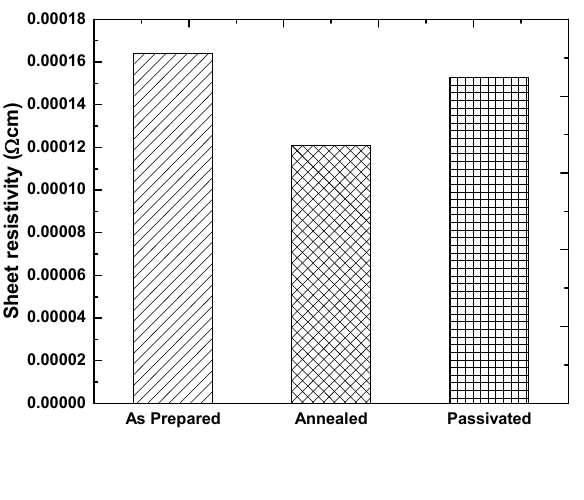
Figure 7. Sheet resistivity comparison for as prepared, annealed and passivated Pd-F:SnO 2 thin